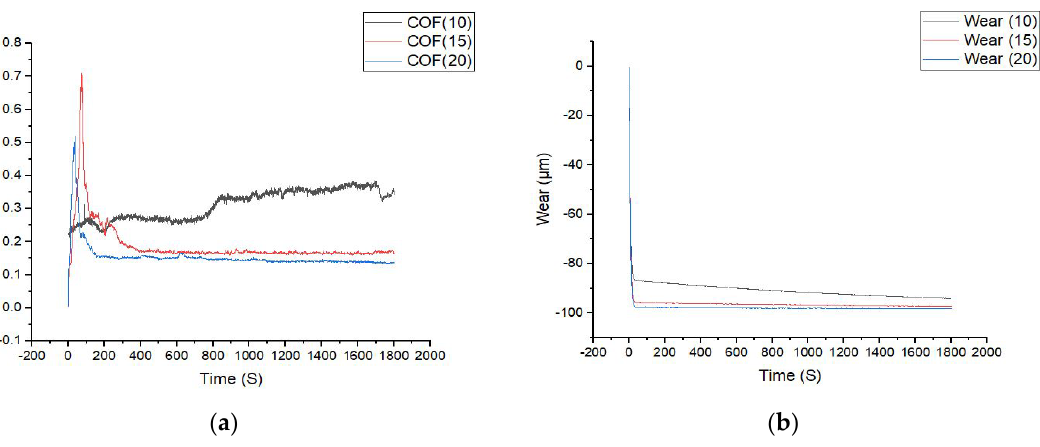
Figure 7. Graphs of ( a ) CoF vs. time and ( b ) wear vs. time.